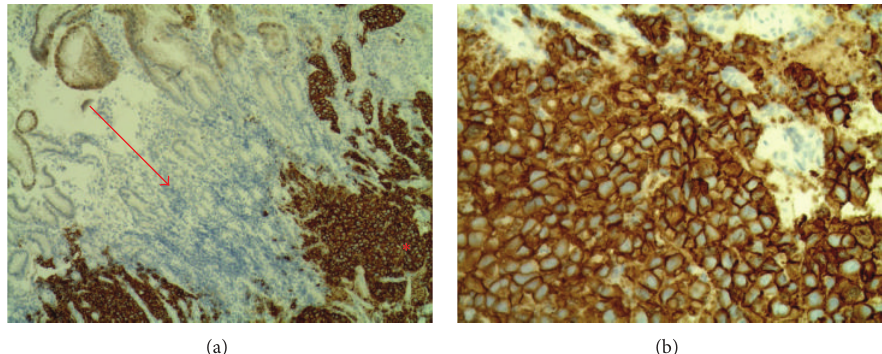
Figure 6: (a) The arrow indicates normal gastric cells (unstained) and asterisk shows Her2+ stained cancerous cells. (b) Shows Her2+ stained gastric cancerous